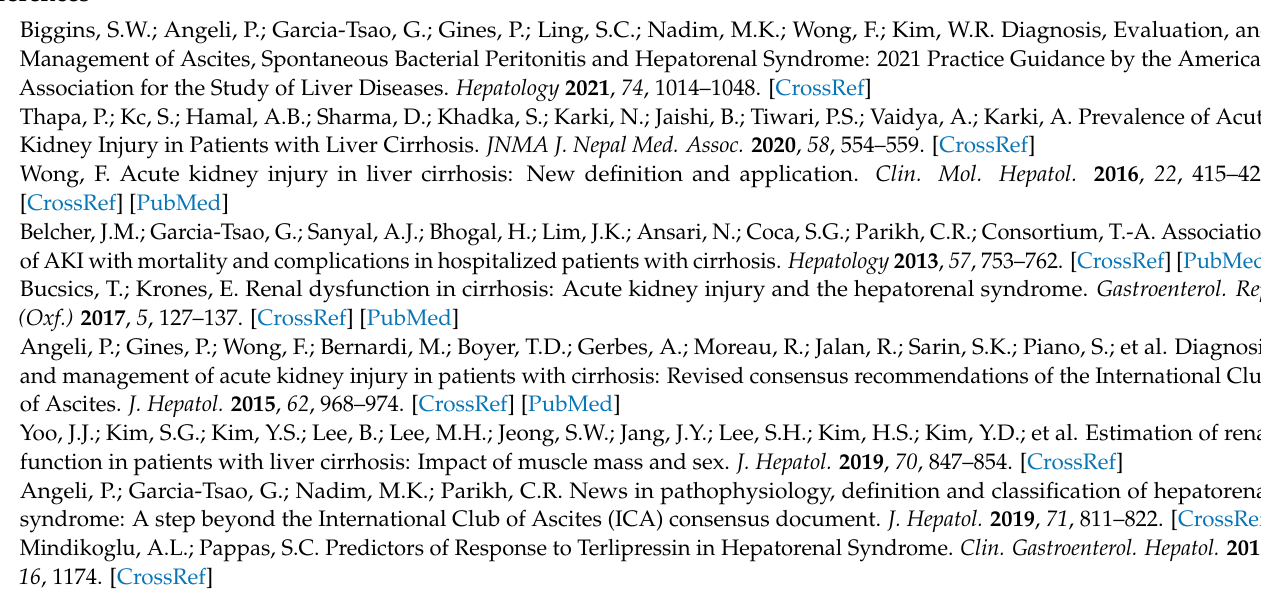
AKI. Table S2: Urine NAG depending upon liver disease severity. Table S3: Baseline characteristics of HRS-AKI. Table S4: Logistic regression analysis for response to terlipressin therapy in patients with HRS-AKI. Figure S1: Transplant free survival according to AKI phenotype. Figure S2: Boxplot comparing mean urine NAG according to AKI recurrence. Figure S3: Urine NAG level according to clinical outcomes. Figure S4: Boxplot comparing mean urine NAG between groups (HRS group). Figure S5: Relationship between delta urine NAG and response to